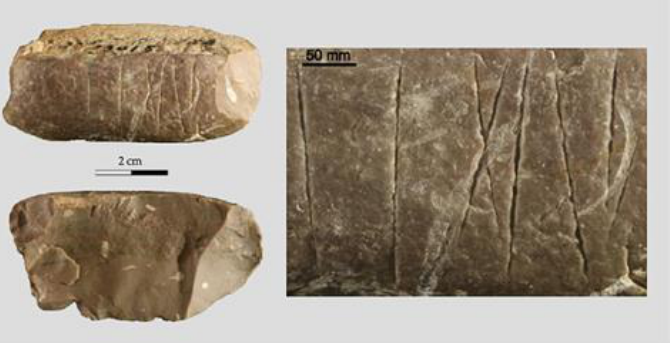
Figure 14. Two views of engraved stone and close-up of the markings, from Shuidonggou Locality 1, central China, probably about 36,000 years